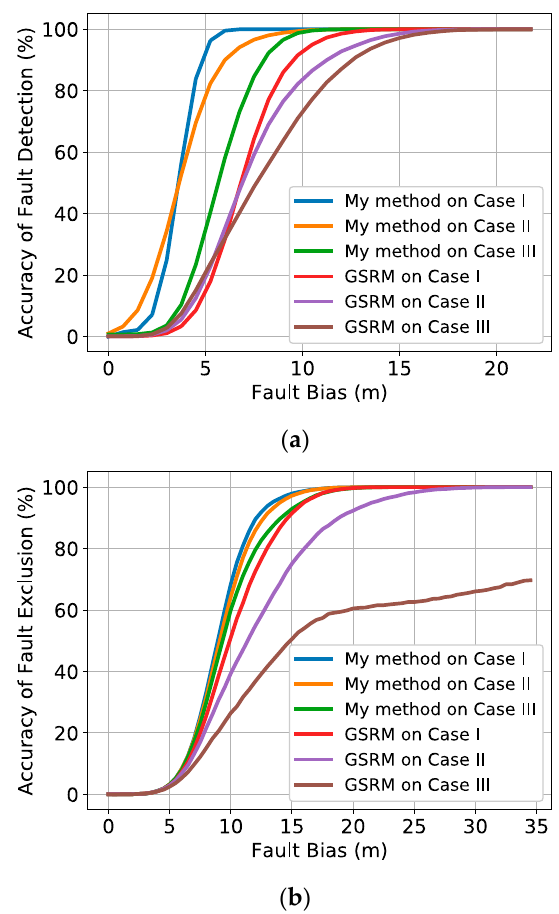
Figure 6. The performance of fault detection and exclusion in three different cases, ( a ) Results of fault detection rate; ( b ) Results of fault exclusion rate. Table 2. Performance of my method and GPS stand-alone RAIM method (GSRM) on different fault bias and 99% Mini- mal Detectable Biases (MDBs), in different